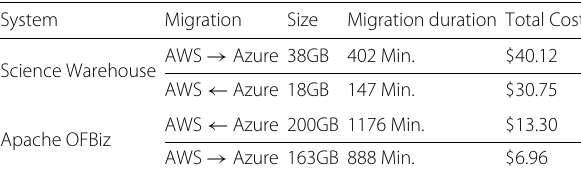
Table 5 Actual migration costs